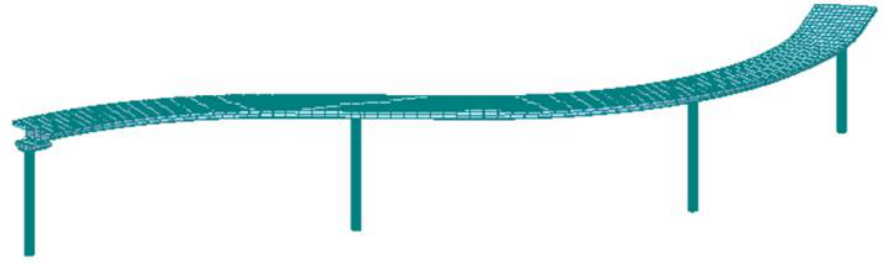
Figure 3. The established three-dimensional finite element model of the investigated bridge. The finite element model was used to analyze the natural frequencies and mode shapes of the bridge through eigenvalue analysis. The analysis results of the natural fre- quencies and the mode shapes of the first five modes are listed in Table 1. Table 1. Natural frequencies and mode shapes of the first five modes.